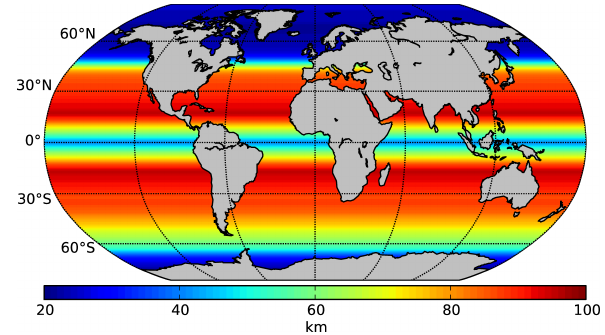
Fig. 13. Horizontal resolution of an example mesh. This mesh is Fig. 3. Horizontal resolution of an example mesh. This mesh is used used in all simulations presented in this work. in all simulations presented in this work.